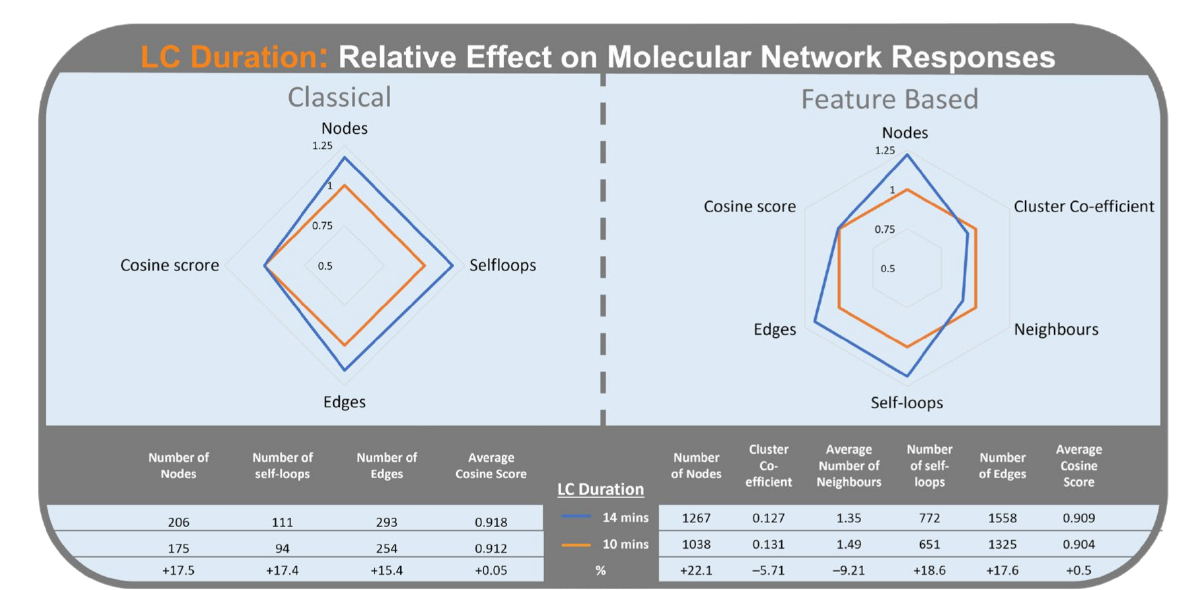
Figure 11. Radar graph of the effect of liquid chromatography duration (10 min in orange) (14 min in blue) on the relative change of responses of Classical Molecular Networking ( left ) and Feature-Based Molecular Networking ( right ).